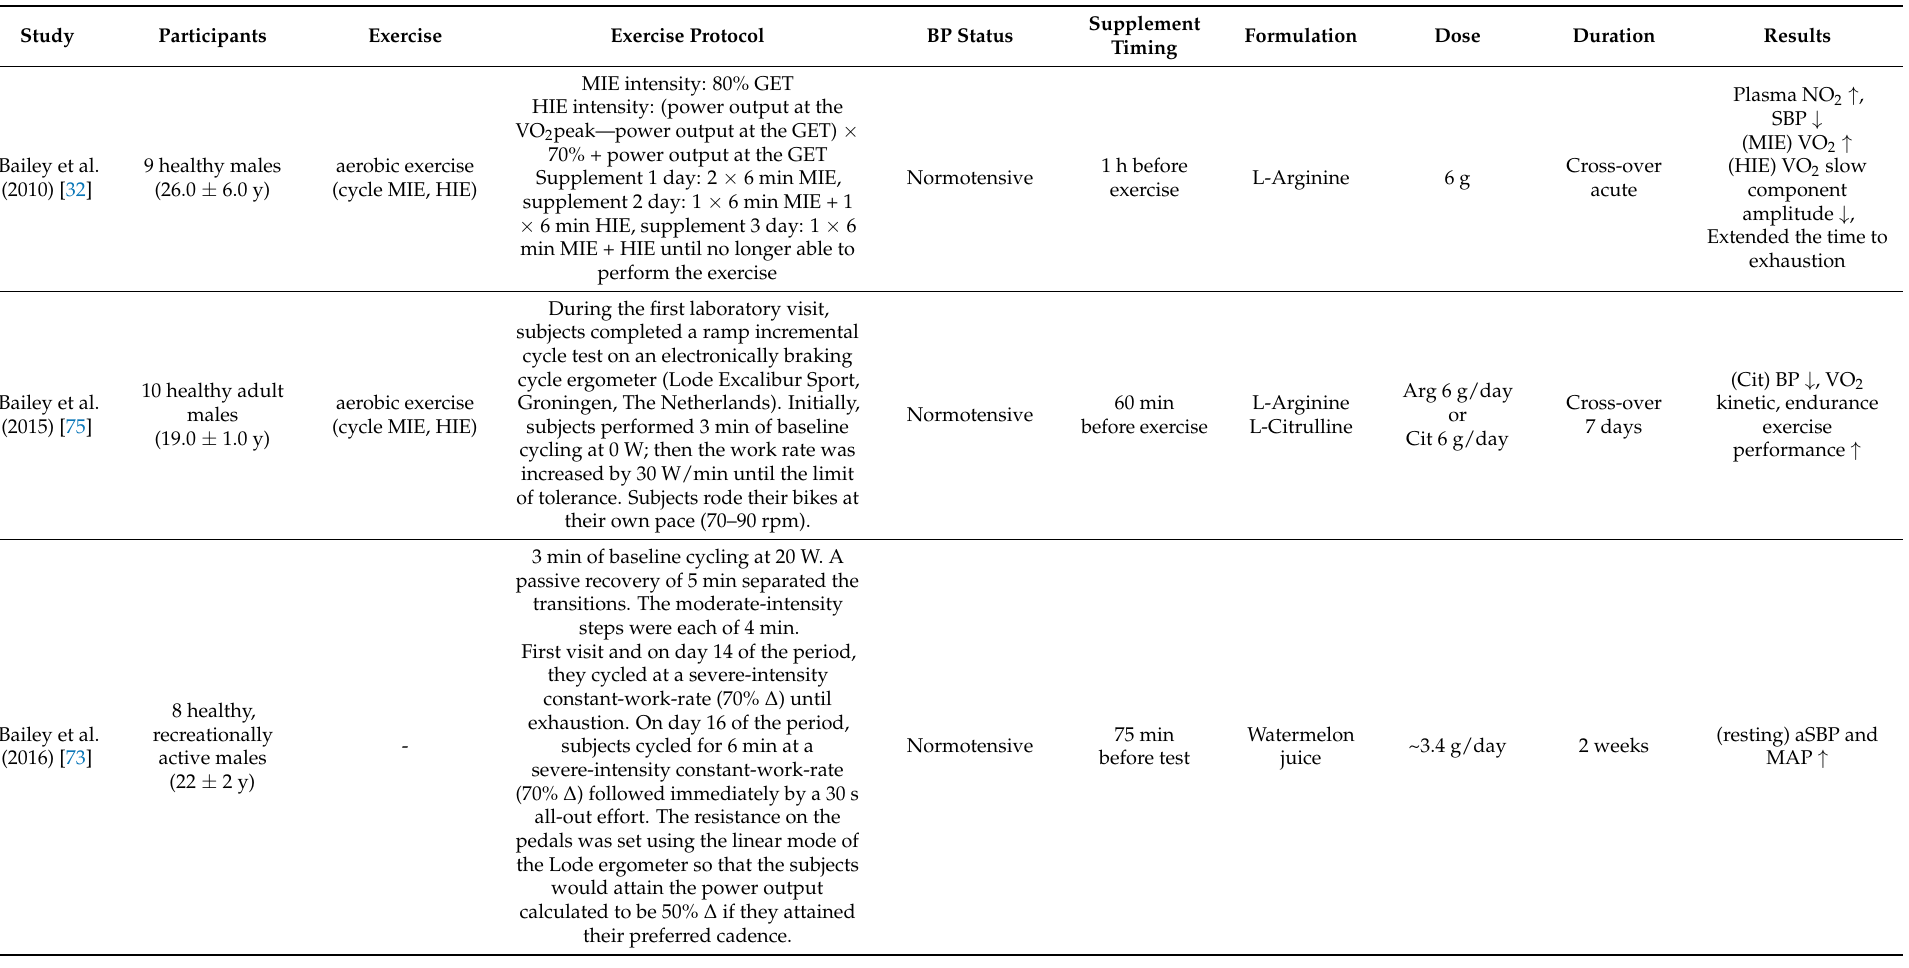
Table 2. The effects of Arg, Cit, and CitMal supplementation on athletic